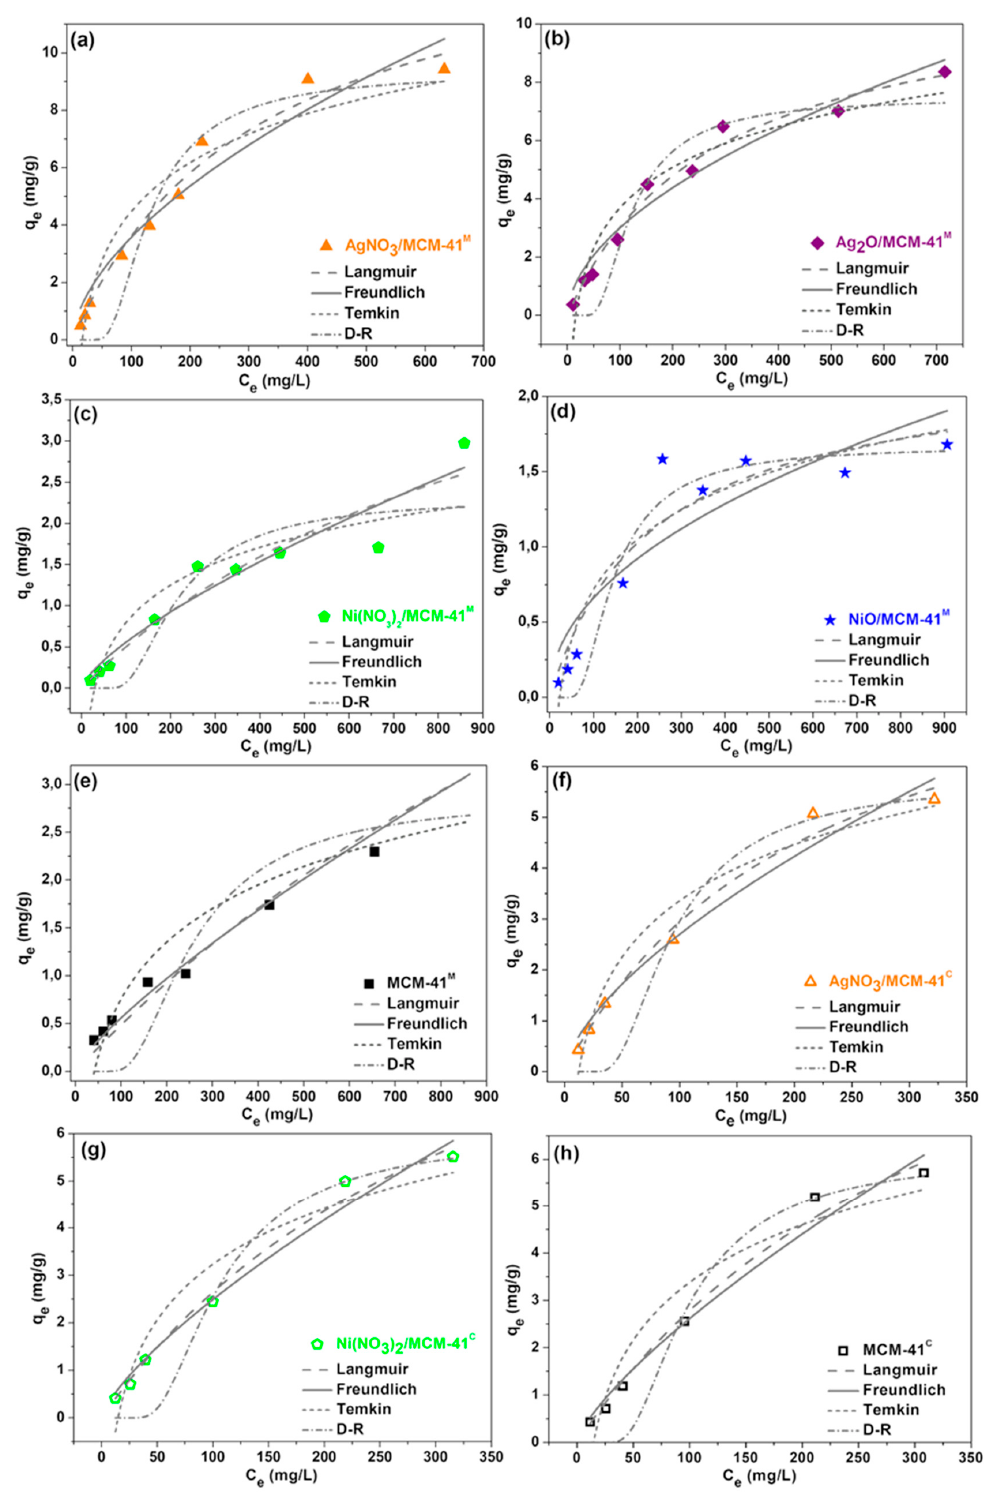
Figure 7. Non-linear adjustments of Langmuir, Freundlich, Temkin and Dubinin-Radushkevich (D-R) equilibrium isotherms of S-compounds adsorption over ( a ) AgNO 3 / MCM-41 M , ( b )Ag 2 O / MCM-41 M , ( c )Ni(NO 3 ) 2 / MCM-41 M , ( d )NiO / MCM-41 M , ( e )MCM-41 M , ( f )AgNO 3 / MCM-41 C , ( g ) Ni(NO 3 ) 2 / MCM-41 C and ( h ) MCM-41 C . Experimental conditions: room temperature and pressure, real diesel with sulfur concecntration ranging from 25 to 1000 ppm.